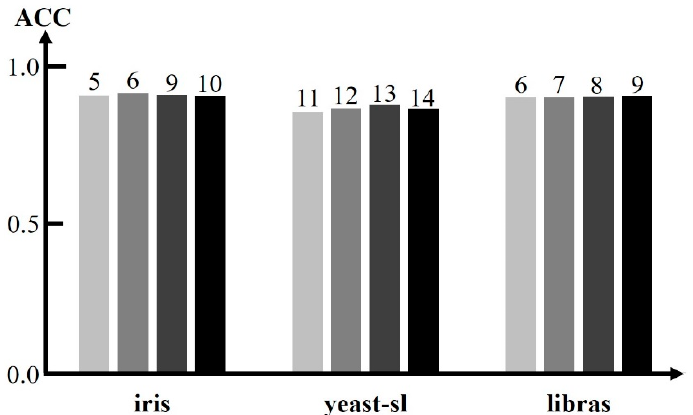
Figure 8. Performance of SL-Scheme with variation in the number of hidden neurons.